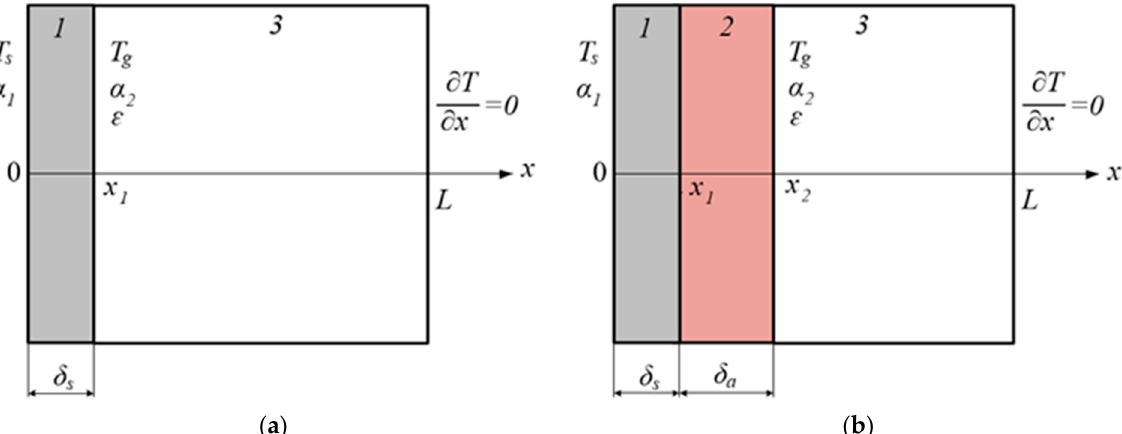
Figure 2. Area for solving the problem of heat transfer from an energy source to a coolant during the formation of a slag layer on a tube surface: ( a ) initial moment of time ( t = 0); and ( b ) moment in the process of a slag layer formation ( t > 0). Designations: 1—steel tube wall; 2—slag layer; 3—heated flue gases.